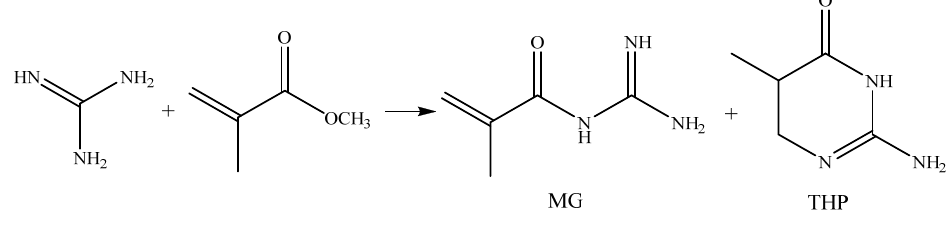
Table 1. Conditions for MG synthesis in